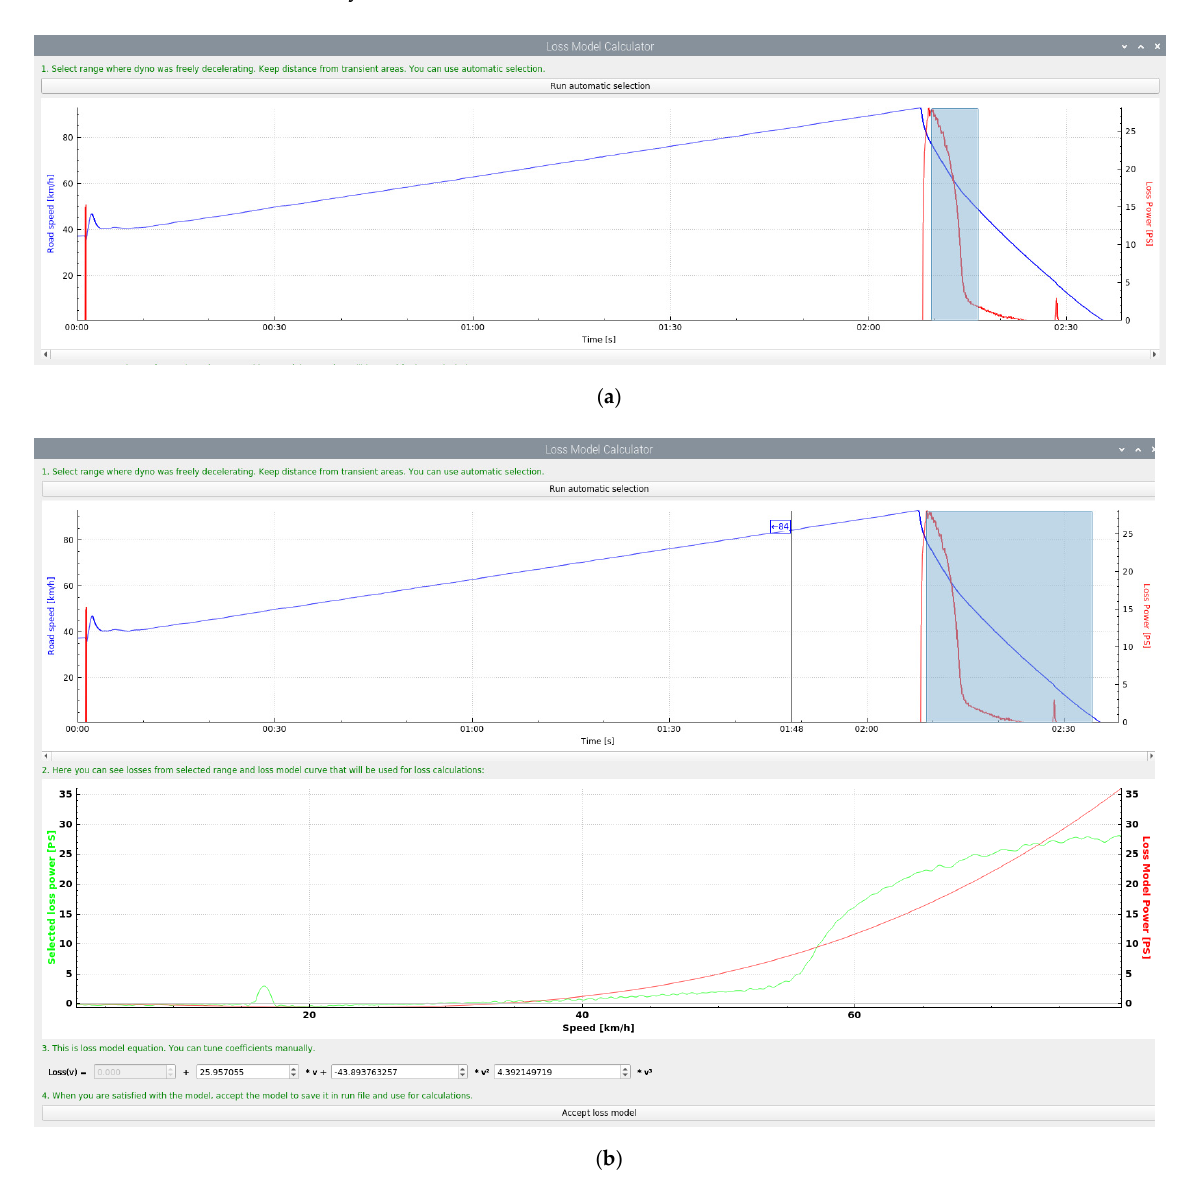
Figure 14. Screen from the dyno software, calculation of the loss model in the drive system: ( a ) nomi- nal settings, ( b ) manually selected range of the loss model, and comparison of the repeatability of the automatic vehicle gearbox operation (authors’